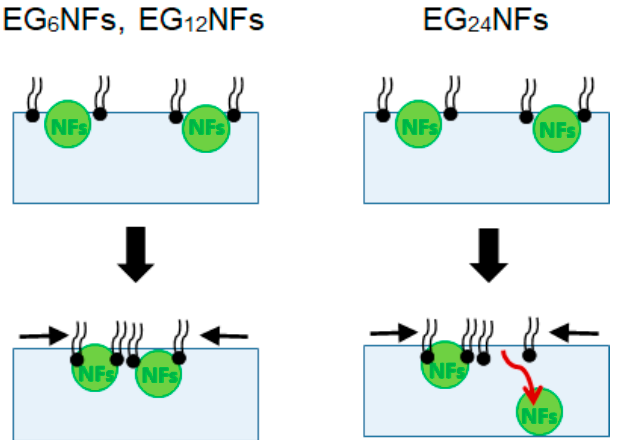
Figure 9. Schematic of the sequence of interactions between the DPPC monolayers and the EG n NFs at the air–water interface.